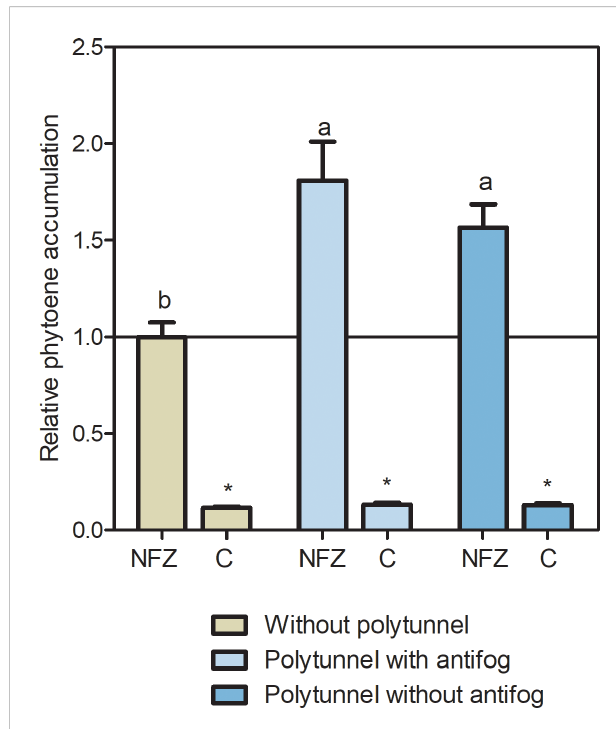
FIGURE 7 Metabolic fl ux of the carotenoid pathway determined with nor fl urazon. Relative phytoene accumulation in lettuce grown without or under polytunnels with and without antifogging additives. Lettuce was treated with the bleaching herbicide nor fl urazone (NFZ) or with water as a control (C). The data are expressed as mean ± SE of two independent experimental repetitions (each with n = 4). Data were normalized to NFZ lettuce cultivation without polytunnels (indicated by the black line). Asterisks indicate signi fi cant differences of NFZ treatment to control (p ≤ 0.05), whereas different letters indicate signi fi cant differences due to cultivation condition (p ≤